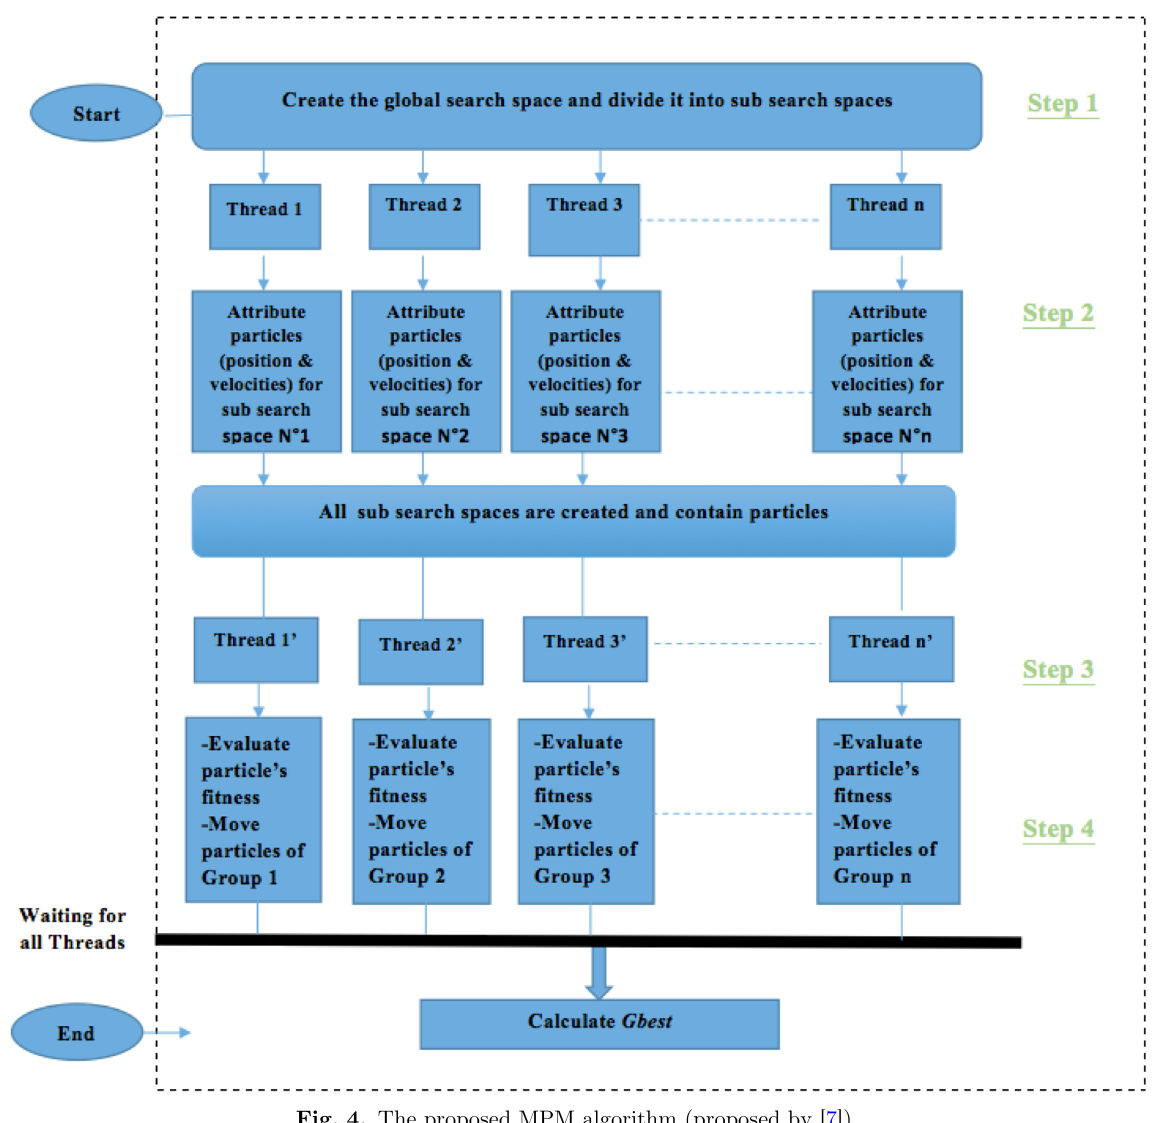
Fig. 4. The proposed MPM algorithm (proposed by